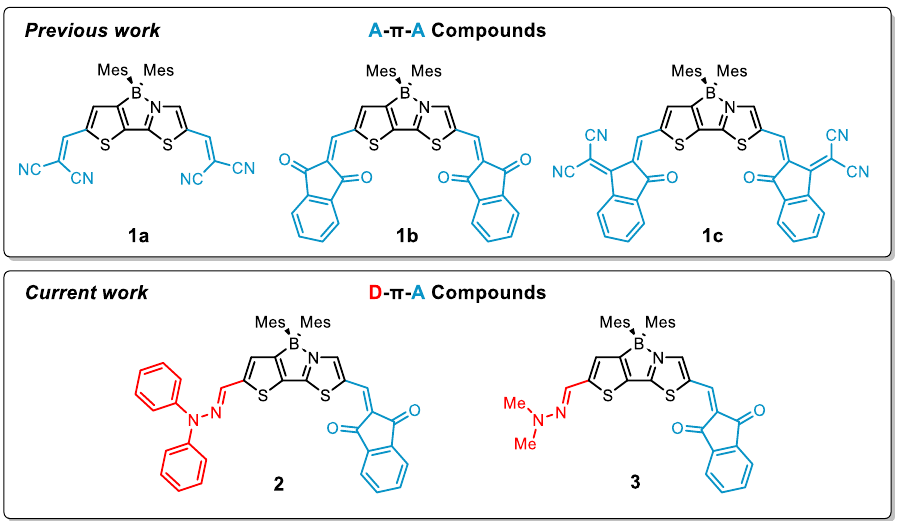
Figure 1. Structural comparison between previous (compounds 1a – c ) and current (compounds 2 and 3 ) work.